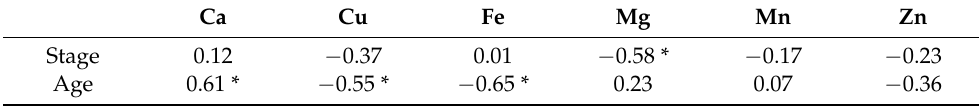
Table 4. The values of the correlation coefficients for the content of analytes in the tissue of men con- sidering age and stage of atherosclerosis. Statistically significant values are marked with an asterisk.